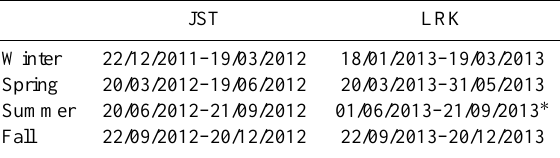
Table 1. Seasonal classification of measurements at JST and LRK is based on direction of angle of the Earth to the sun and the angle of the sunlight as it hits the